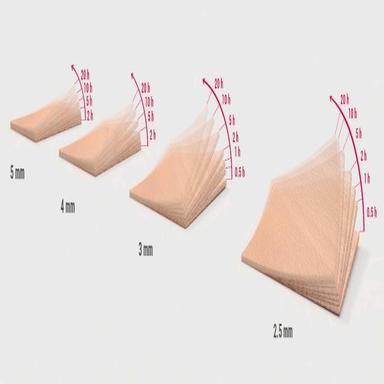
Rendering of the samples simulated through the algorithm. The overall bending and the velocity of bending decrease as the thickness increases.